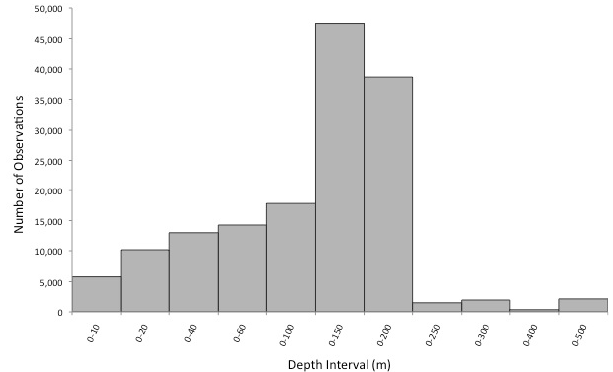
Figure 3. Distribution of original sampling depth. Depth interval 0–10 corresponds to zCAT i010; depth interval 0–20 corresponds to zCAT i020, etc. (see Table 4).